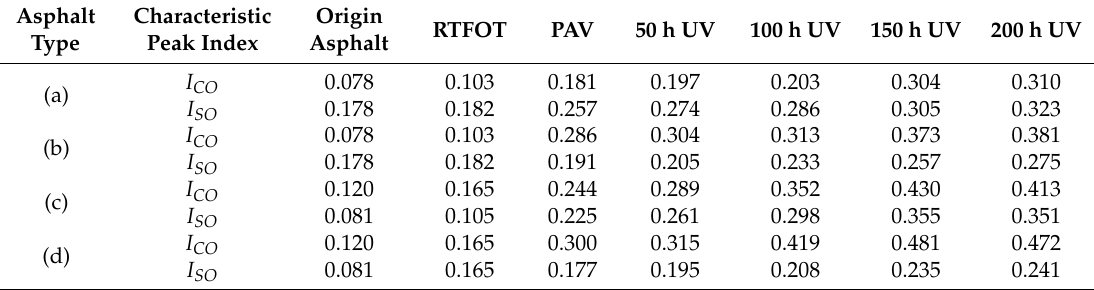
Table 3. WMA’s I CO and I SO before and after